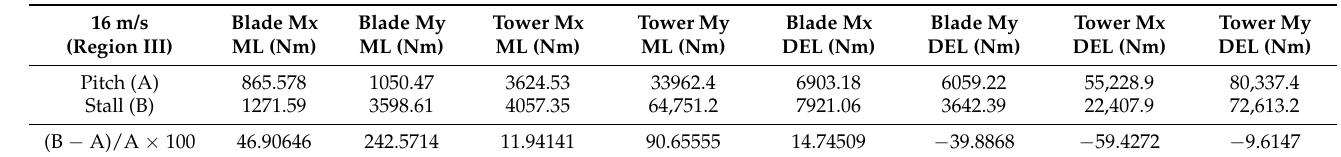
Table 5. Quantitative comparison of load according to controller at above rated wind speed (Re- gion